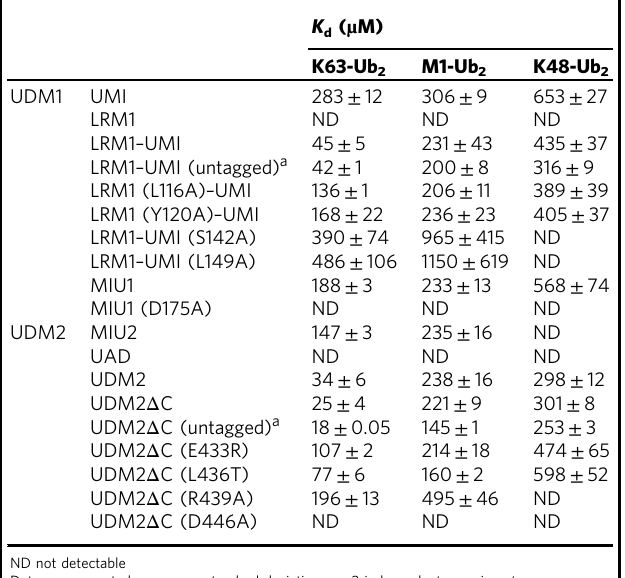
Table 1 Binding af fi nity of UMI, LRM1, LRM1 – UMI, MIU2, UAD, or UDM2 Δ C for K63-, K48-, or M1-Ub